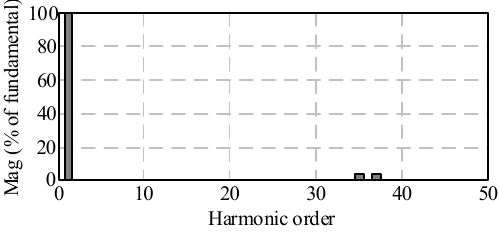
Figure 7. The spectrum of input line current i a under the optimal parameters.